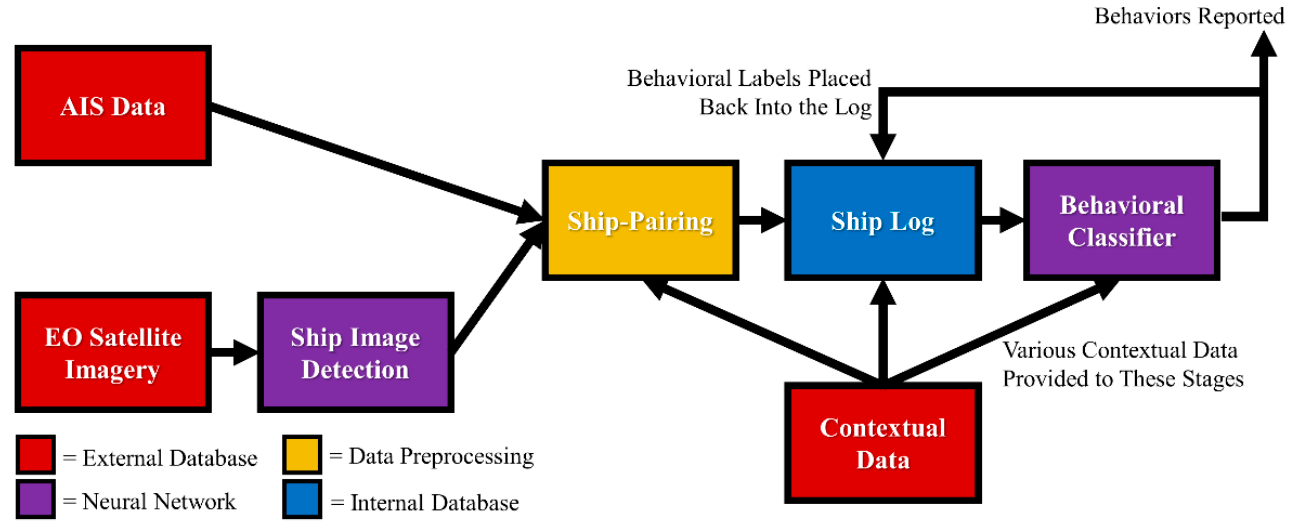
Figure 1. Data flow of the BATMAN framework.